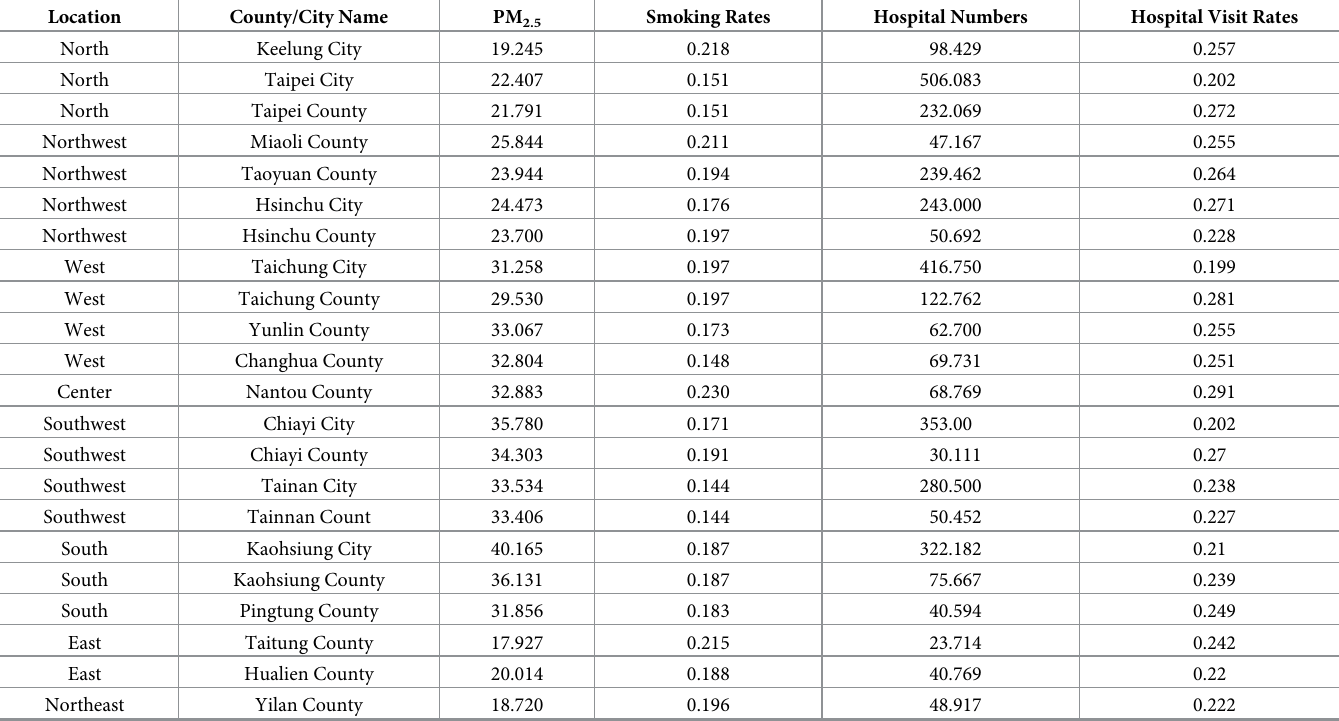
Table 2. Average values of PM 2.5 concentrations (after Kriging), smoking rates, hospital numbers, and hospital visit rates for respiratory diseases, in 22 second-level administrative regions in Taiwan. The geographical locations of each region in Taiwan are also reported.